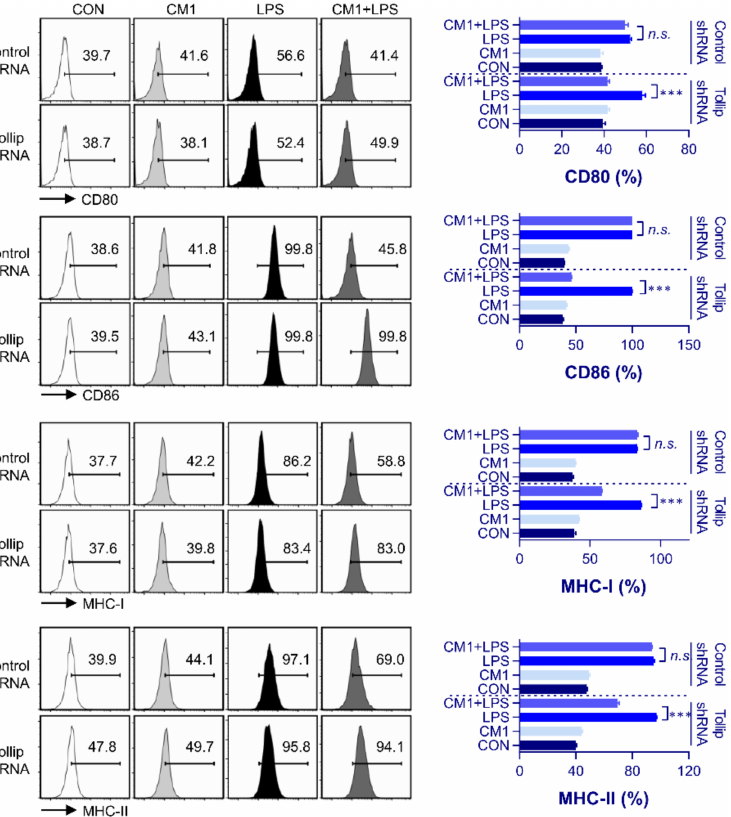
Figure 3. CM1-mediated suppression of macrophage surface marker expression through upregulation of Tollip expression. Control and Tollip shRNA-transfected RAW264.7 cells were pretreated with CM1 (2 µ g/mL) for 1 h and then exposed to LPS (200 ng/mL) for 24 h. Cells were stained with anti-CD80, anti-CD86, anti-MHC class I, and anti-MHC class II. The percentage of positive cells is shown in each panel. Data are presented as the mean ± SD for triplicate determinations of one representative plot among three independent experiments. Statistical analysis was performed by one-way ANOVA in conjunction with Tukey’s multiple test; n.s : no significance and *** p < 0.001, versus LPS treatment alone. Abbreviations: Tollip, Toll-interacting protein; shRNA, short hairpin RNA; LPS,